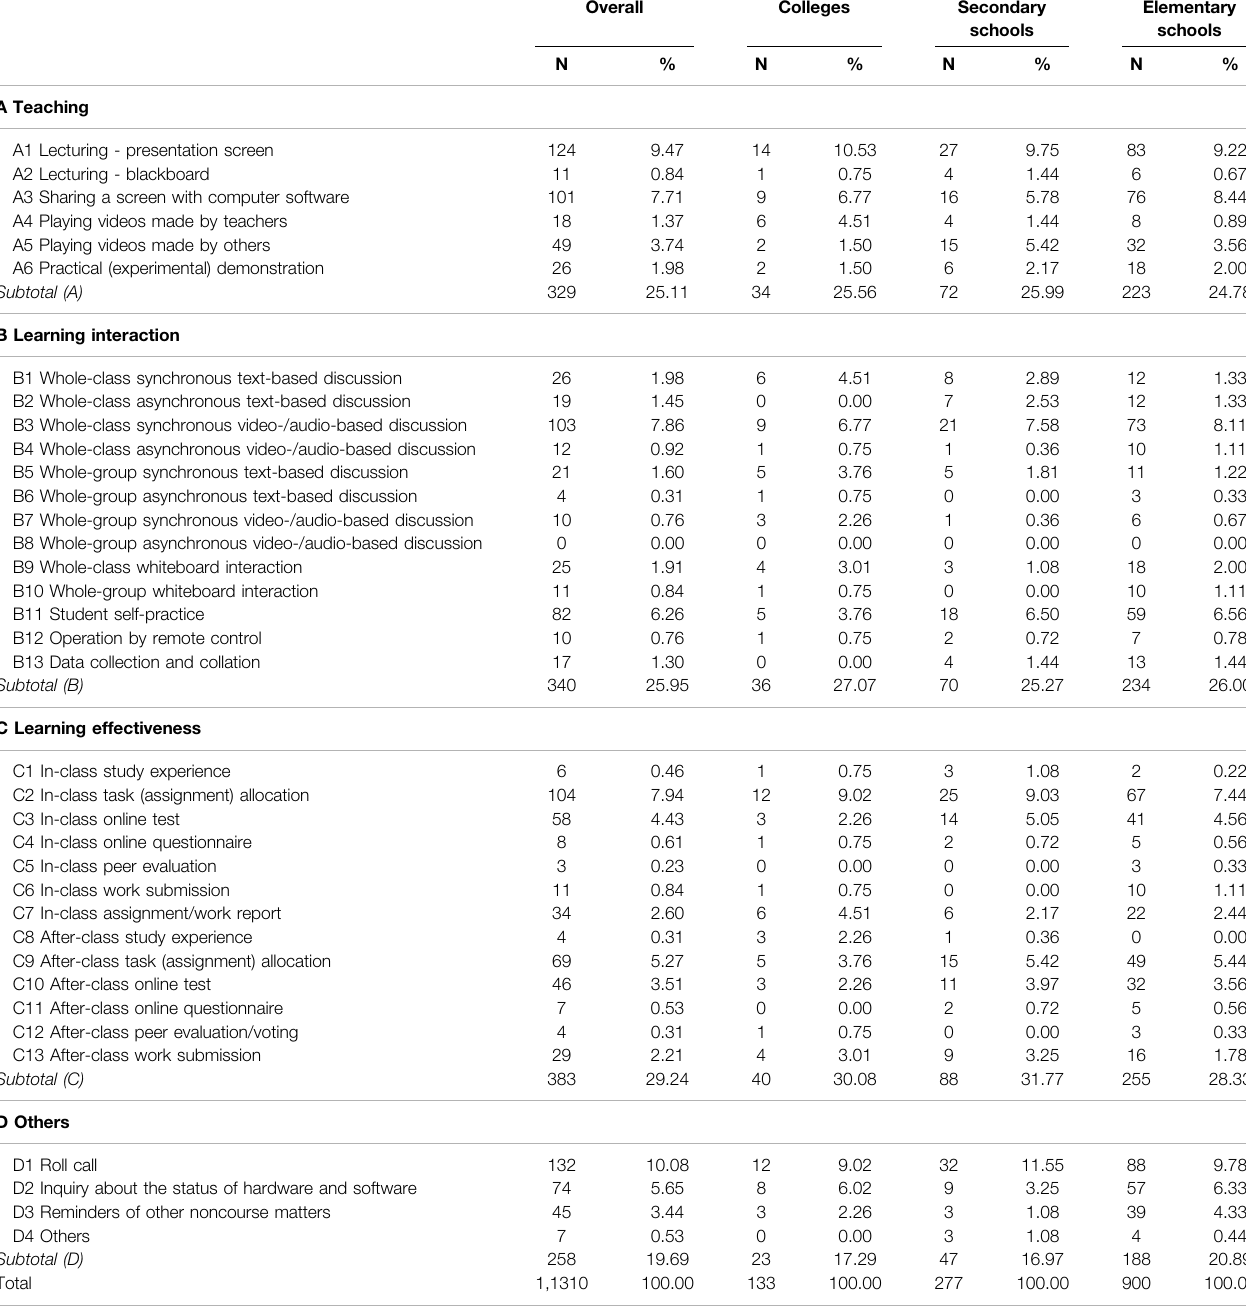
TABLE 2 | Number and percentage of various instructional